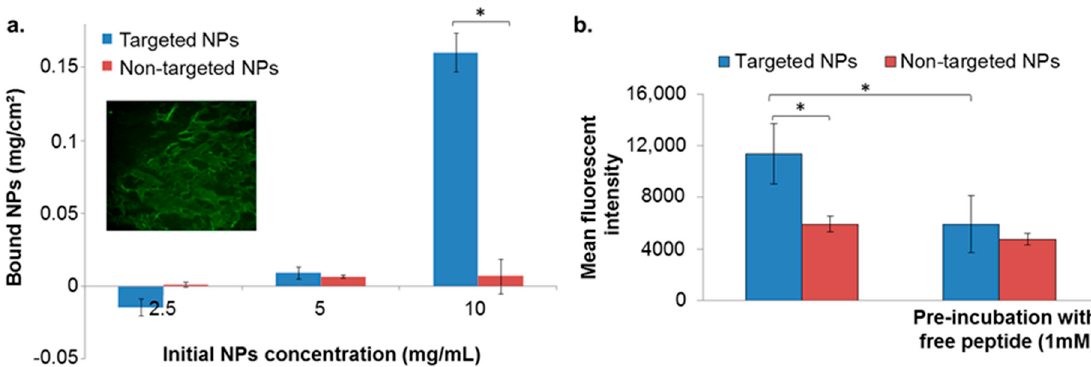
Figure 2. NPs binding to extracellular matrix (ECM) isolated from endothelial cells ( a ), and to basement membrane ( b ). Data is presented as mean ± SD, * p < 0.05. Validation of ECM matrix presence in the coated well is shown in the inset ( a ) conducted by fluorescent labeling for heparan sulfate proteoglycan (HSPG) (perlecan protein; basement membrane-specific heparan sulfate proteoglycan core protein).